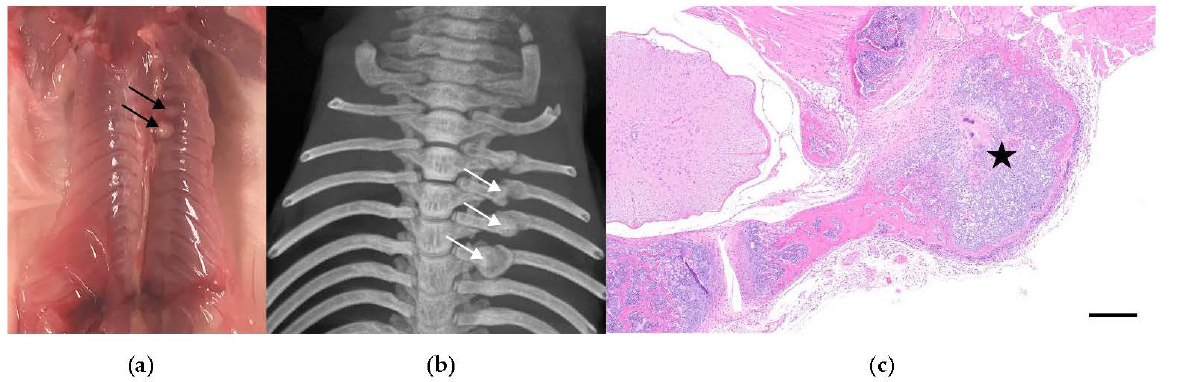
Figure 1. Example of rib fracture in a heavily manipulated mouse. ( a ) Macroscopic image showing multiple rib fractures (black arrows). ( b ) Micro-CT scan of the thorax confirming the multiple rib fractures (white arrows). ( c ) H&E photomicrograph of one of the affected ribs showing the fracture site with osteocartilaginous callus formation (star). Scale bar, 300 µ m.